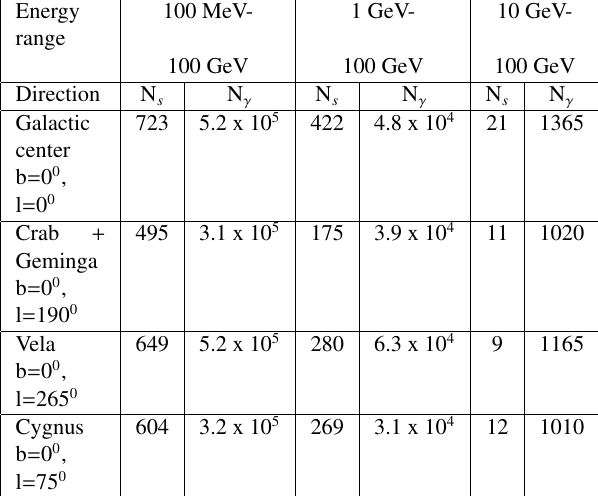
Figure 7. Galactic center, Fermi Bubbles, Crab, Cygnus, Vela, geminga and other regions will be observed with the GAMMA- 400 FoV of 45 0 ± Table 1. Expected number of sources, N s , and gammas, N γ , for di ff erent energy ranges, when GAMMA-400 will observe several regions during 100 days